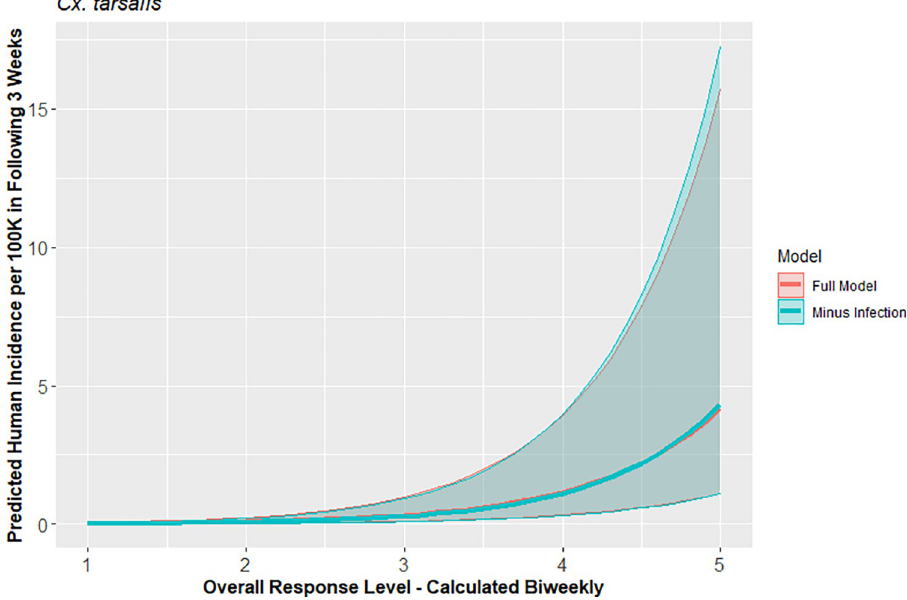
Fig 5. Comparison of predicted human WNV incidence using Cx . tarsalis -based response level models including all environmental components vs best drop-out model, with 95% confidence intervals, in California, 2009–2018.